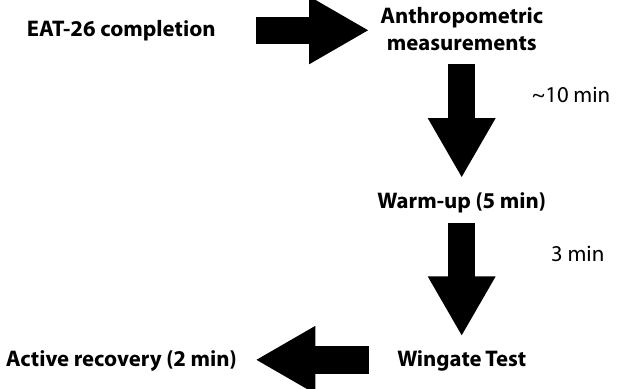
Figure 1 . Experimental design of the present